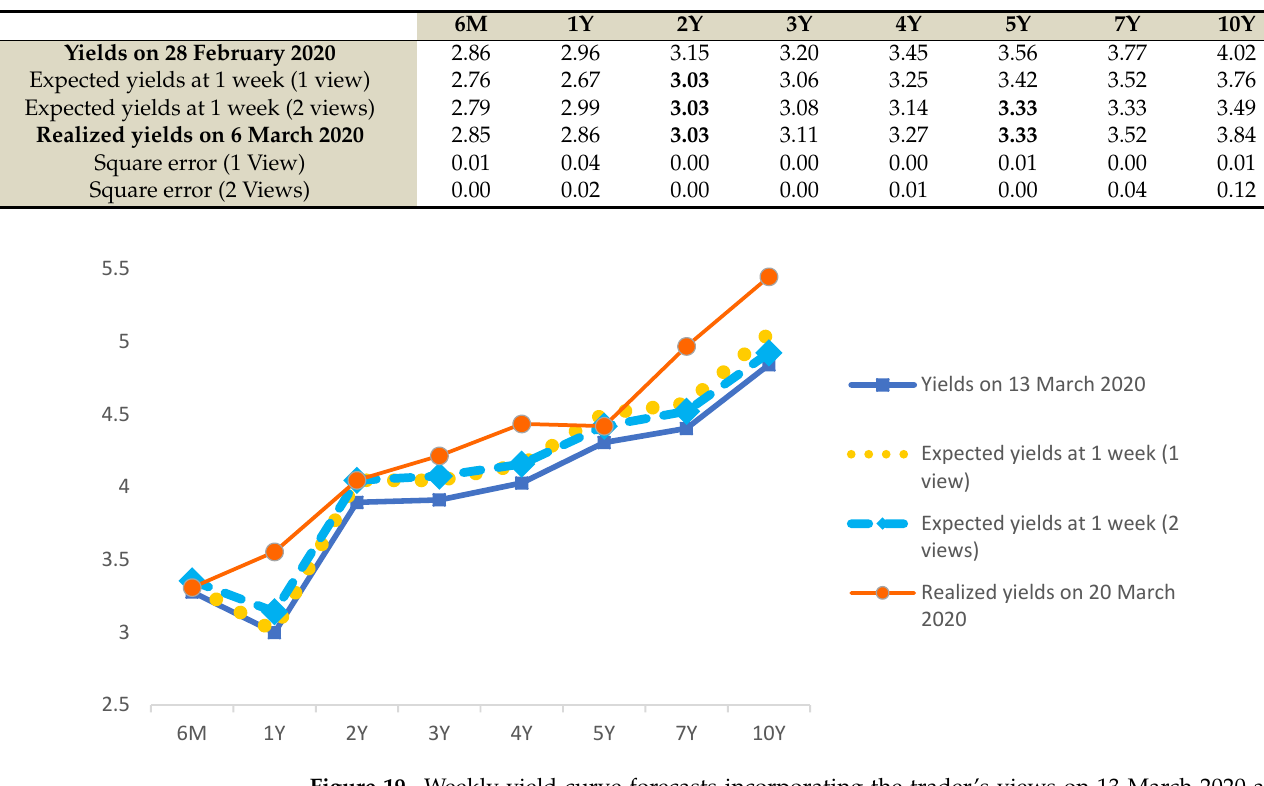
Table 11. Weekly yield curve forecasts incorporating the trader’s views on 28 February 2020 and realized yields on 06 March 2020. Source: Bloomberg, own computation.